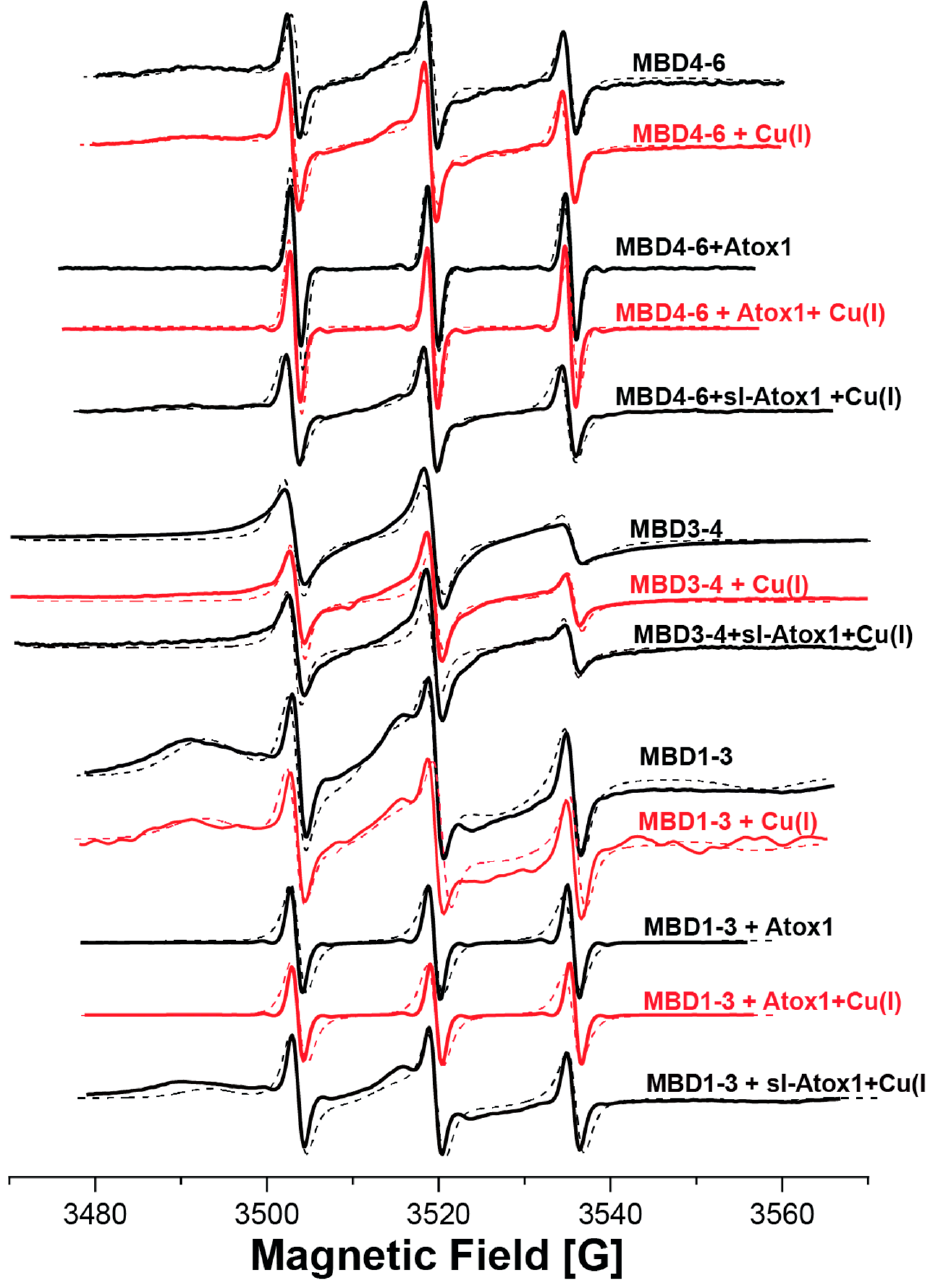
Figure 3. Room-temperature continuous wave (CW) EPR spectra (solid lines) of the various MBDs in the presence and absence of Cu(I), Atox1, and sl-Atox1 (spin-labeled Atox1). The dotted lines denote the simulated spectra using the parameters listed in Table 1. The CW-EPR spectra of MBD3-4 were already reported in reference [23]. Table 1. Simulated parameters for CW-EPR spectra obtained with the easyspin, chili method, in the presence of two species at a g tensor of [2.0087 2.006 2.0022]. Sample